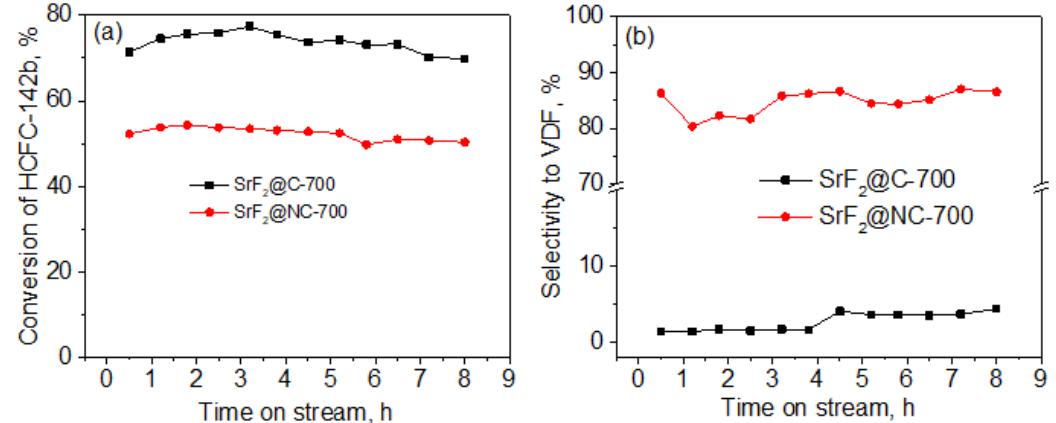
Figure 5. Catalytic performance of SrF 2 @C and SrF 2 @NC catalysts calcined at 700 ° C for the decomposition of HCFC-142b. ( a ) Conversion of HCFC-142b and ( b ) selectivity to VDF. Reactions were carried out at 350 ° C, 1 bar, GHSV (HCFC-142b) of 600 h −1 with N 2 :HCFC-142b of 1:1.